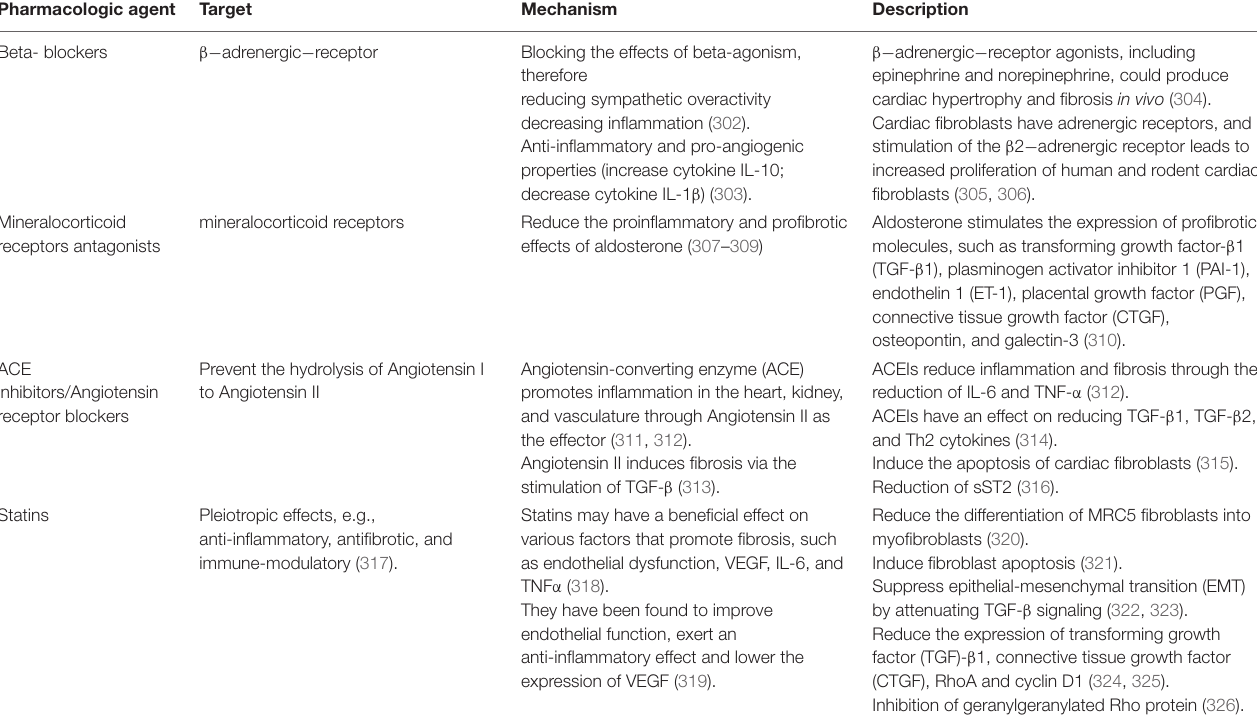
TABLE 1 | Potential antifibrotic mechanisms of currently used pharmacologic